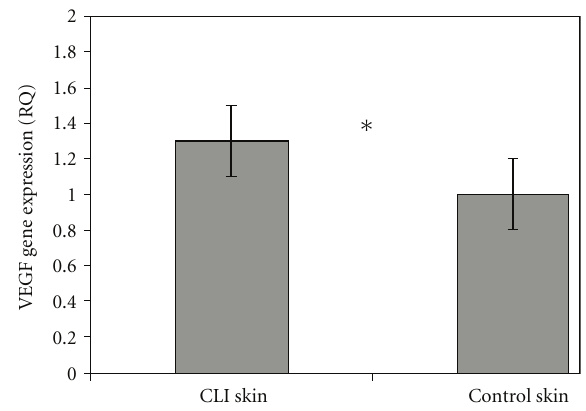
Figure 1: Comparison of the VEGF gene expression for the skin tissue between the CLI group and the control group using the ΔΔ CT method. Error bars express the RQ values of 95% confidence interval. ∗ means statistical